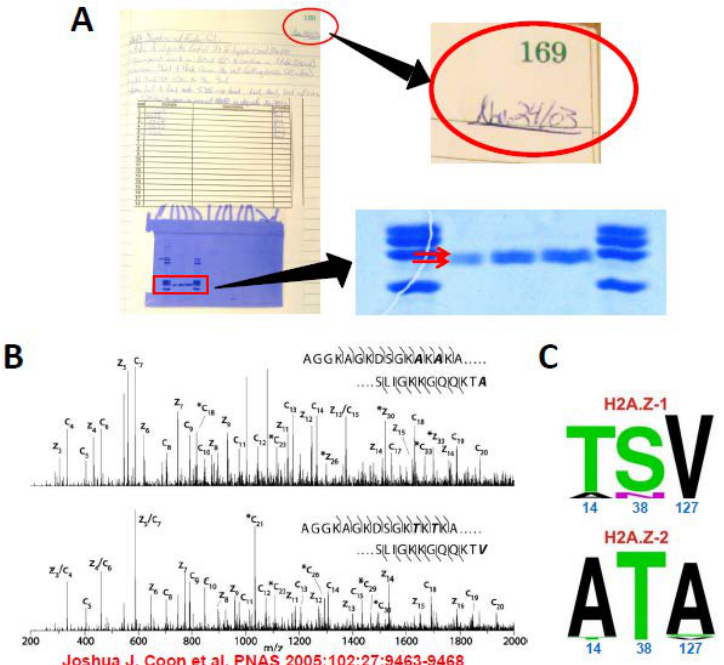
Figure 1. ( A ) First evidence (2003) for purified chicken liver histone H2A.Z running as a double